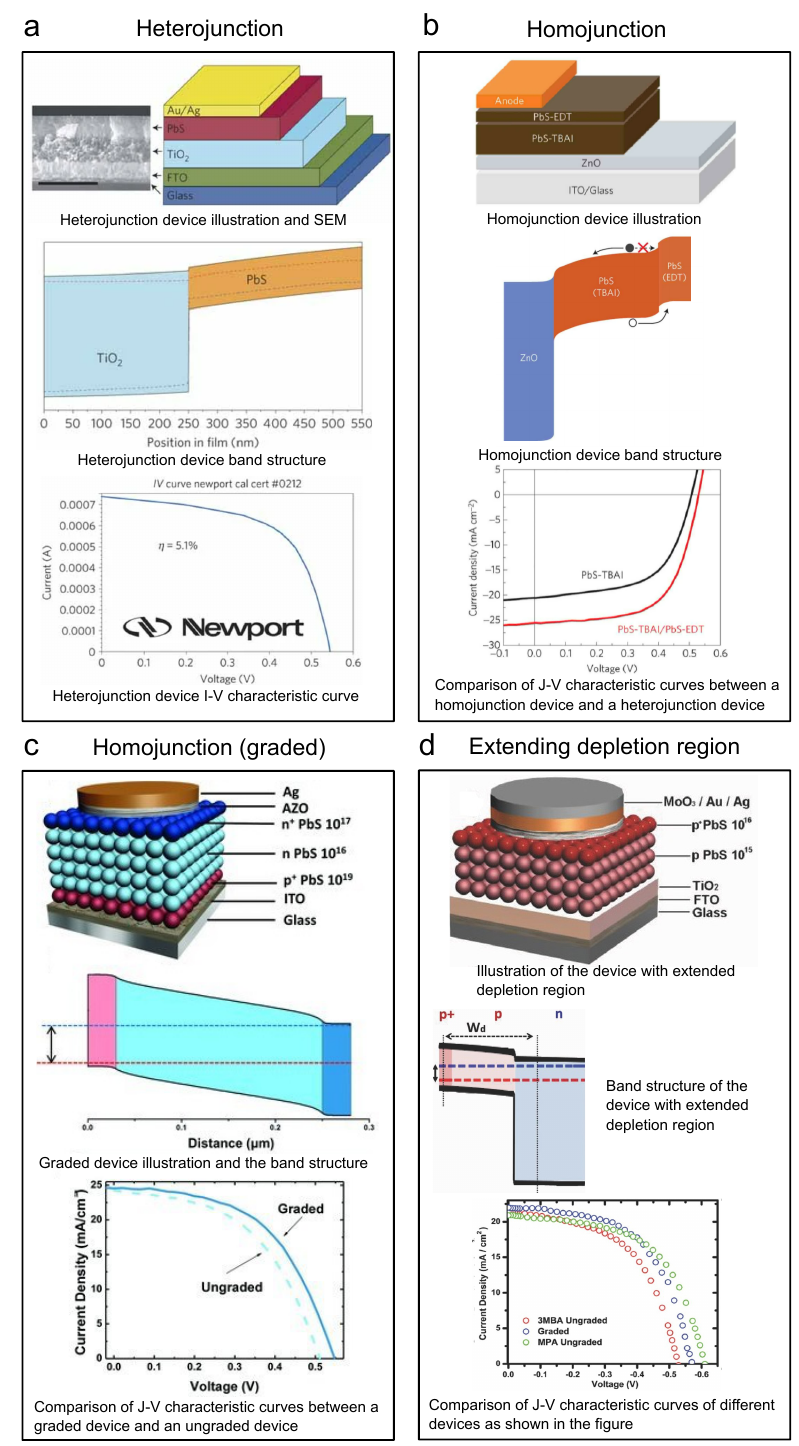
Figure 10. Key graphs of iconic lead sulfide CQD solar cells. Every panel shows the device structure, band structure, and I–V (J–V) curve of the device: ( a ) Heterojunction PbS CQD solar cell.